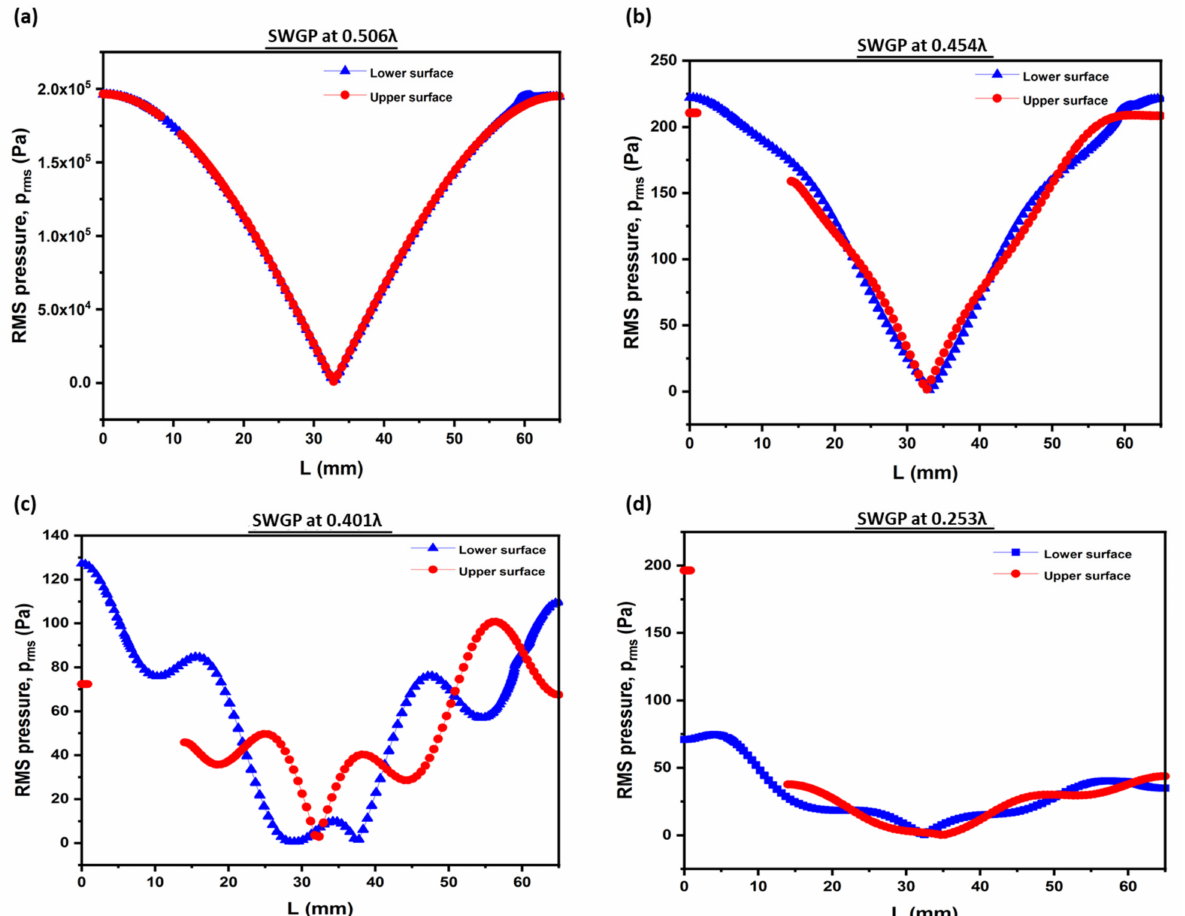
Figure 10. Comparison of the RMS pressure of the upper and lower surfaces of standing wave-source chamber when ( a ) SWGP was actuated at 0.506 λ , ( b ) SWGP was actuated at 0.454 λ , ( c ) SWGP was actuated at 0.401 λ , and ( d ) SWGP was actuated at 0.253 λ